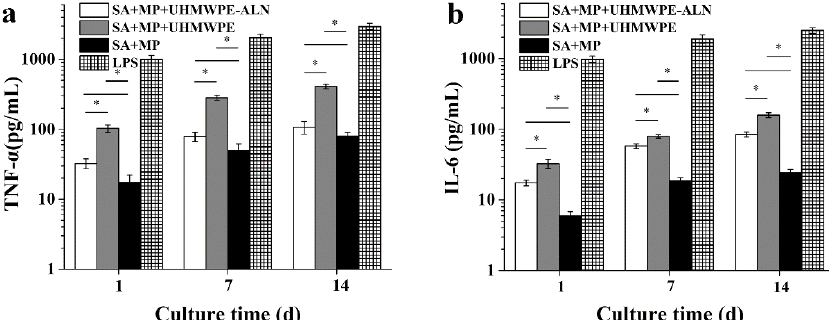
Figure 4. The secreted levels of TNF- α ( a ) and IL-6 ( b ) from macrophages after being co-cultured with critical-sized UHMWPE-ALN wear particles in cell reactors for 1, 7, and 14 d ( n = 3, * p < 0.05). The level of IL-6 ( a ) or TNF- α ( b ) of each group at the same culture time was significantly lower than that of the LPS group (not marked).